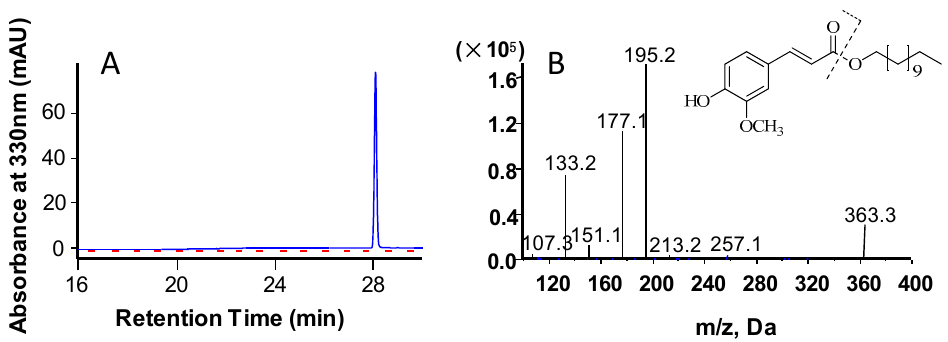
Figure 3. SDS-PAGE separation of recombinant MeHFT. Lane M: molecular mass standards. Lane 1: culture medium from E coli cells harboring an empty pET32a vector control; lane 2: proteins purified from the culture medium used in lane 1; lane 3: culture medium from E coli cells harboring pET32a-MeHFT; lane 4: proteins purified from the culture medium used in lane 3.